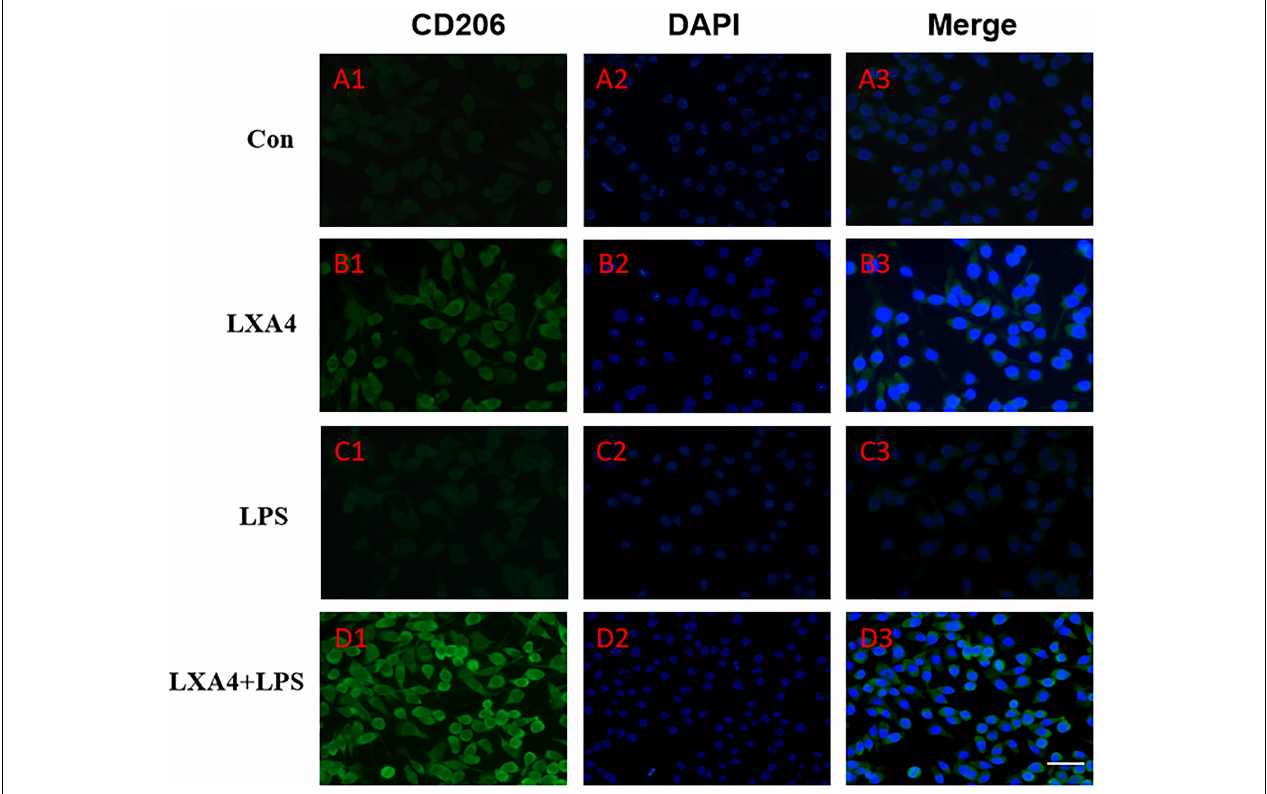
FIGURE 7 | Immunofluorescence images showing the BV2 microglia after LPS stimulates which were not labeled with CD206 antibody, with LXA4, the expression of Arg1 is expressed at high level. Green fluorescence indicated CD206 positive cells, while blue fluorescence indicated DAPI-labeled nuclei. Scale bar: 20 µ m.